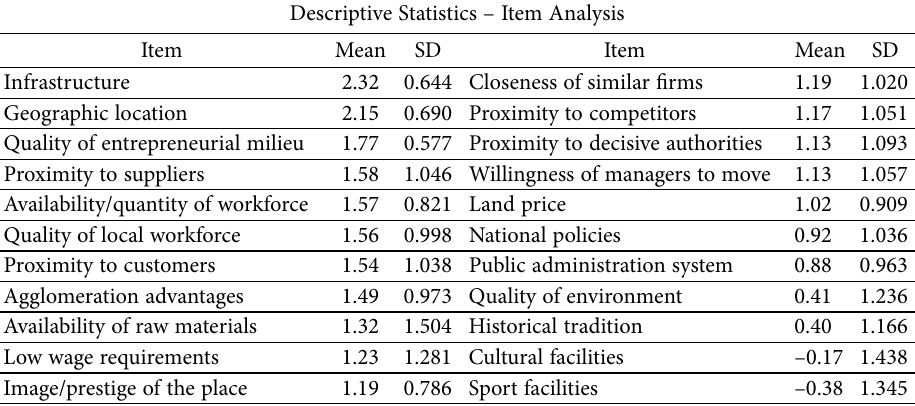
Table 3. Fundamental attributes of examined location